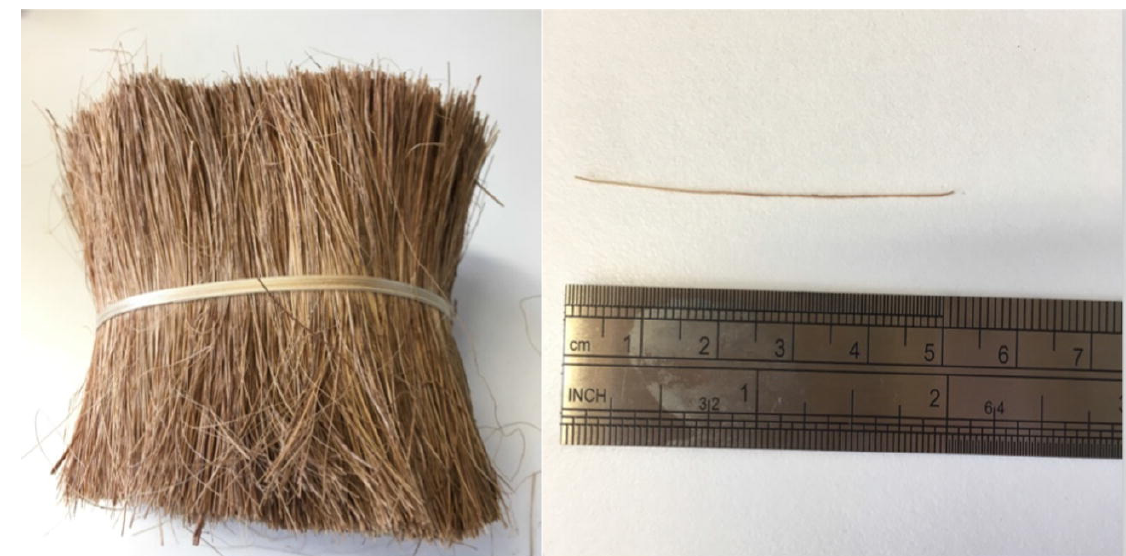
Figure 11. Coconut fibers used to improve concrete properties. Reprinted with permission from [110]. Copyright© 2017, Elsevier B.V.